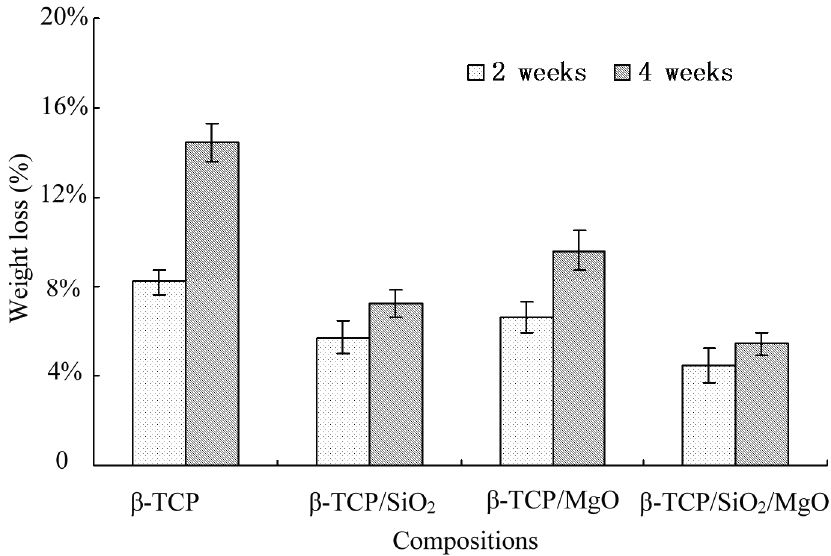
Figure 6. Weight loss (in wt %) of the scaffolds in